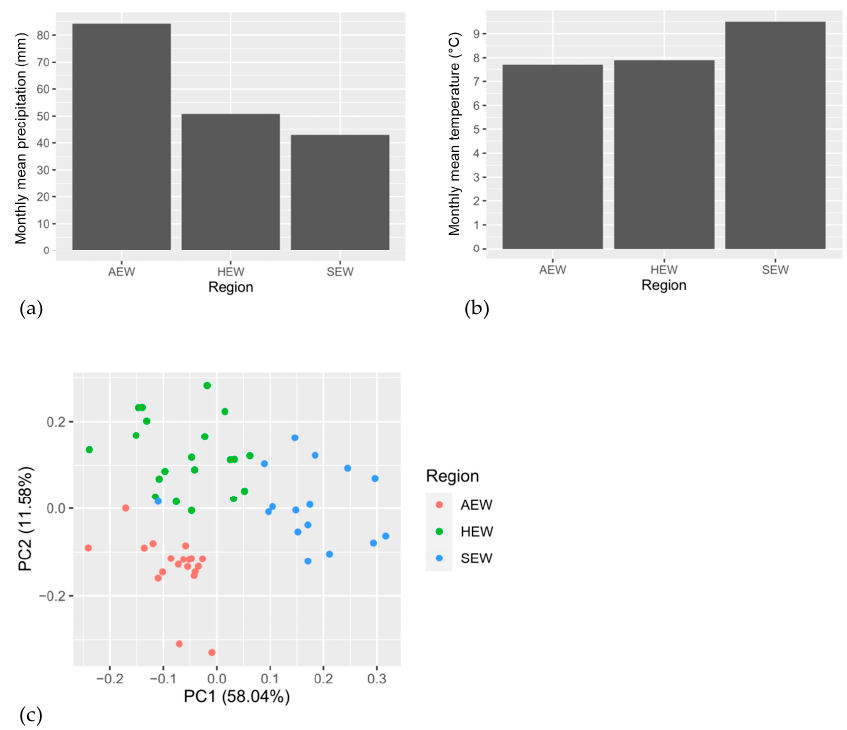
Figure 1. Monthly mean precipitation ( a ) and monthly mean temperature ( b ) over all plots for the observation period of the experiment (September 2012 to November 2015), and ( c ) separation of the experimental plots of the three analyzed regions based on a PCA of climate data for the observation period of the experiment.